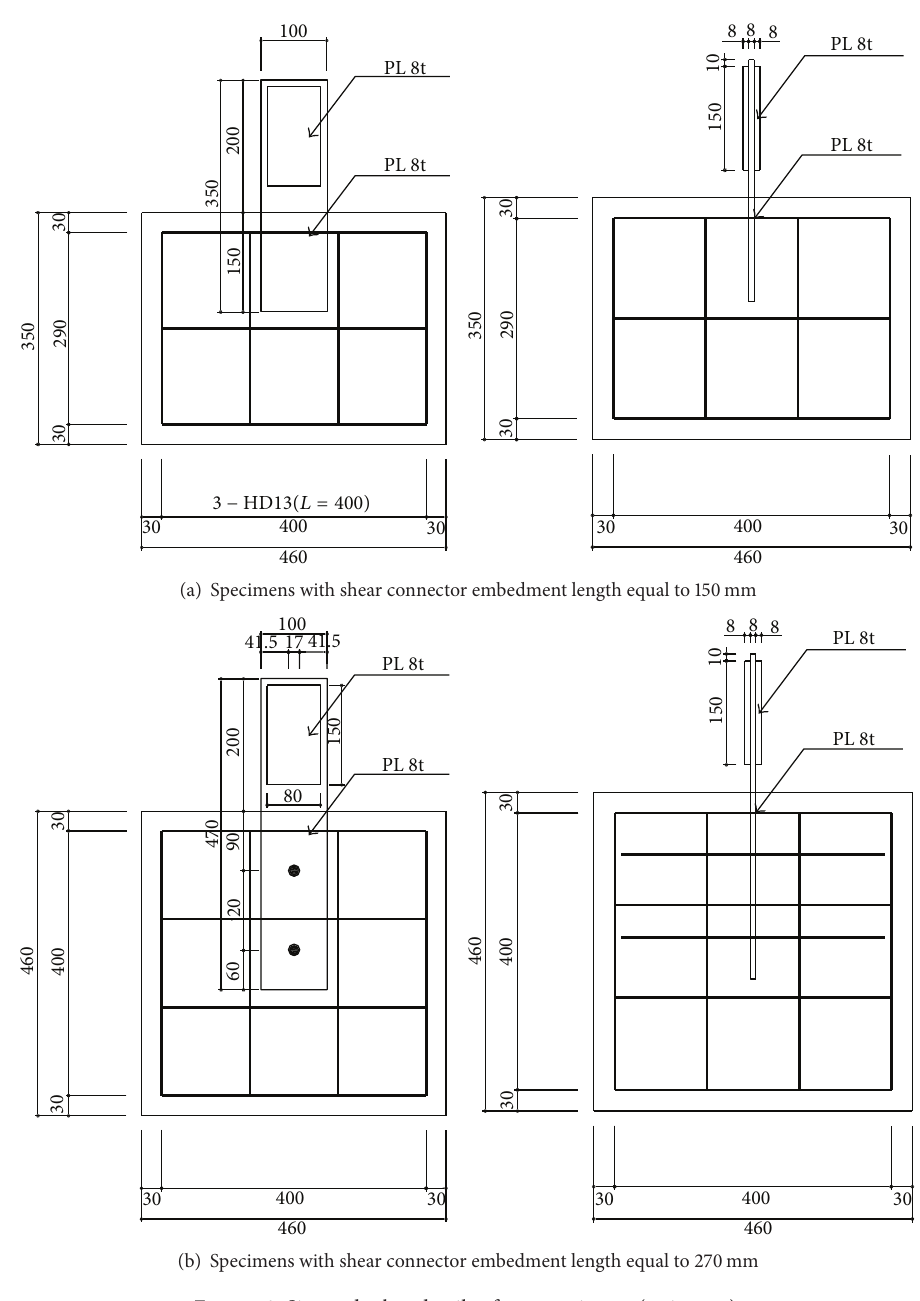
Figure 3: Size and rebar details of test specimens (unit: